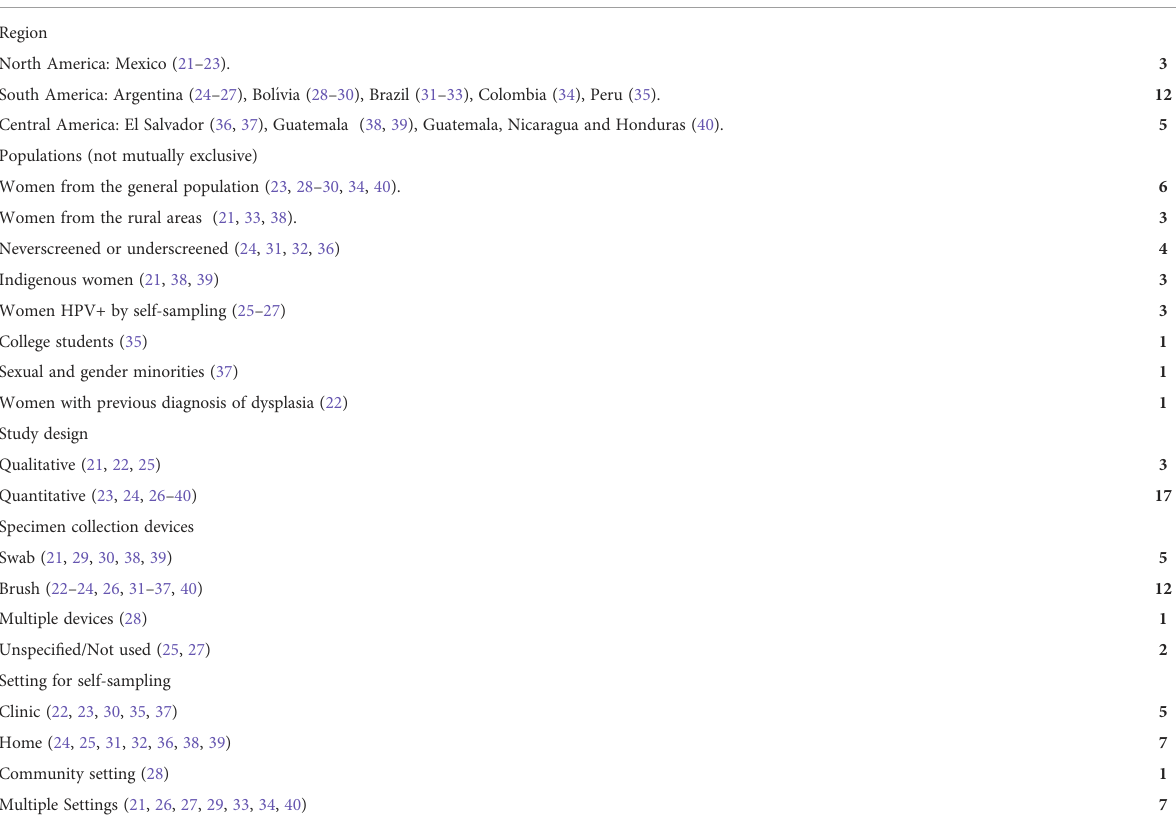
TABLE 1 Summary description of included